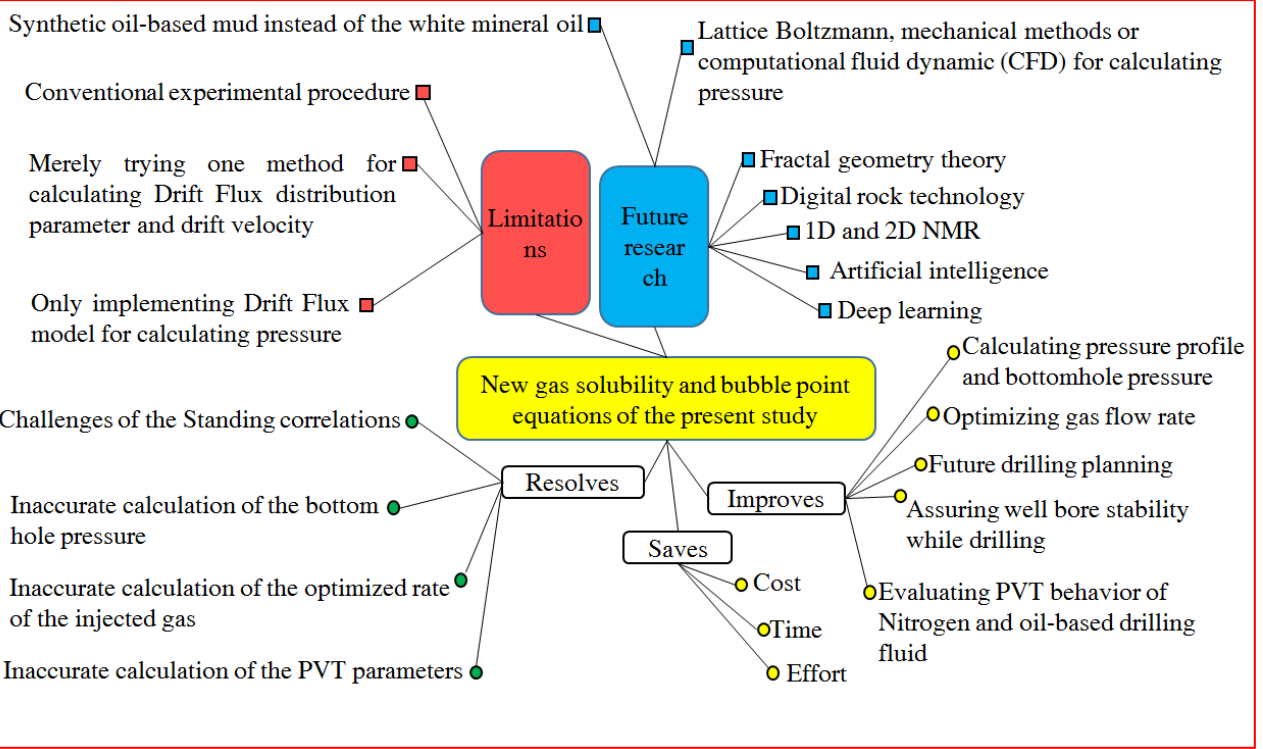
Figure 12. A detailed look into the limitations as well as possible future extensions to the present